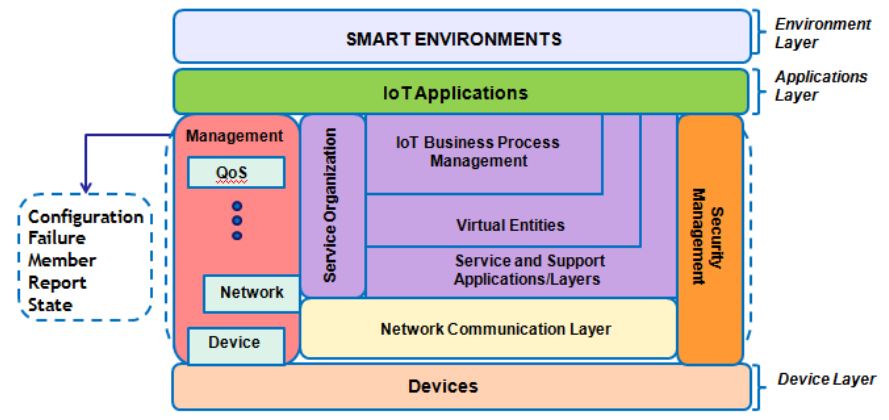
Figure 2. Internet of Things Reference Architecture